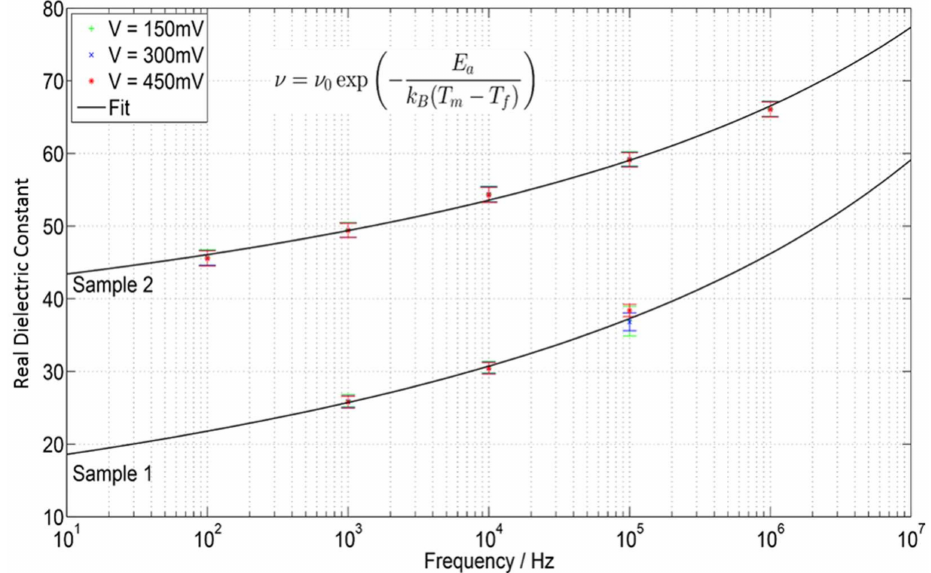
Figure 3. Real part of the dielectric constant for the two Ga-substituted lead hexaferrites shown in Figure 2. The solid curves are fits to Vogel-Fulcher